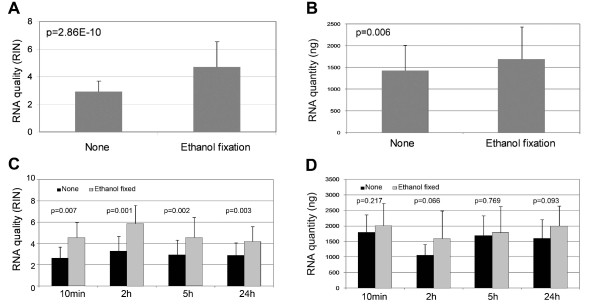
Effect of ethanol fixation on RNA quality and quantity. A) RNA quality (RIN scores) of the tissue sections in the presence (n = 24) and absence (n = 24) of ethanol fixation; B) RNA quantity (ng) of the tissue sections in the presence (n = 24) and absence (n = 24) of ethanol fixation; C) RIN scores of the tissue sections over four time points in the presence (n = 6 per time point) and absence (n = 6 per time point) of ethanol fixation and D) RNA quantity (ng) of the tissue sections over four time points in the presence (n = 6 per time point) and absence (n = 6 per time point) of ethanol fixation. Error bars indicate the corresponding SD. The large errors of the experiments were due to the fact that each tested group consisted of three different tissue types (normal, adenoma and carcinoma) which had the different RNA quality and quantity.